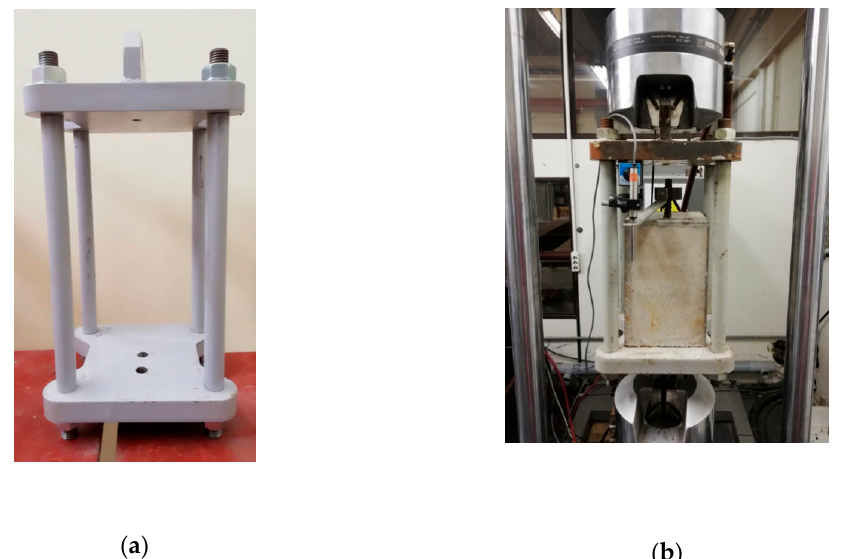
Figure 6. ( a ) Apparatus designed for pull-out testing, in order to transfer the force from reinforcing bar to concrete. ( b ) Experimental pull-out test on semi-embedded steel reinforcing bar.